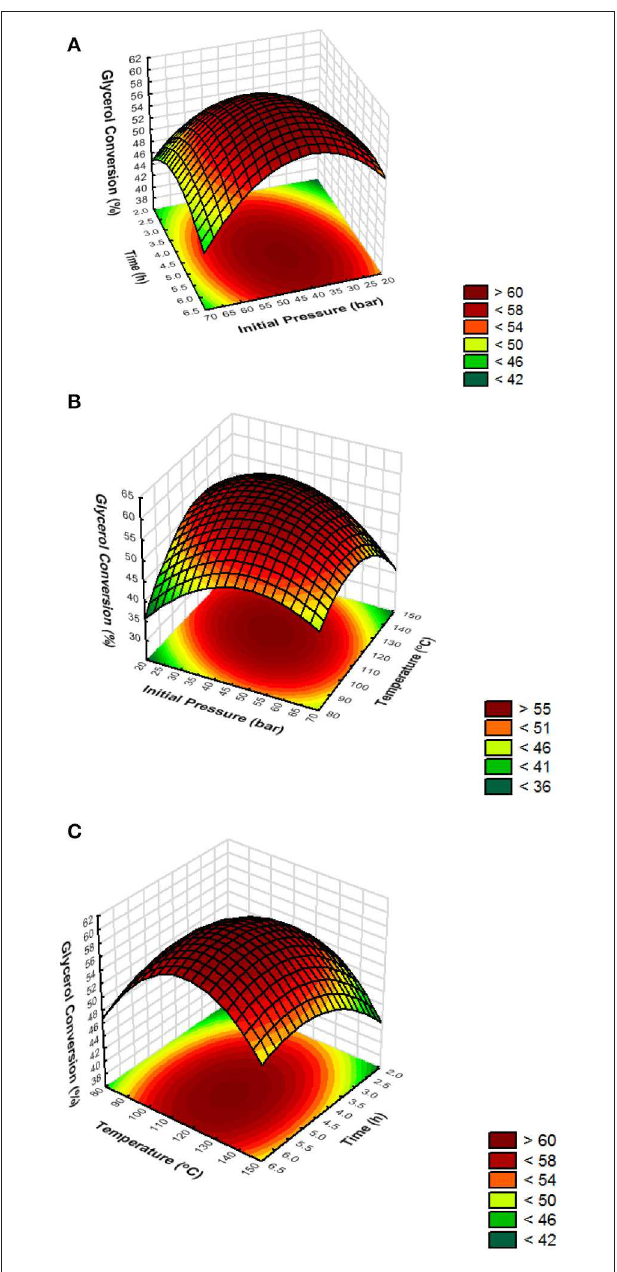
FIGURE 1 | Response Surface of time against initial pressure (A) ; temperature against initial pressure (B) and temperature against time (C) .